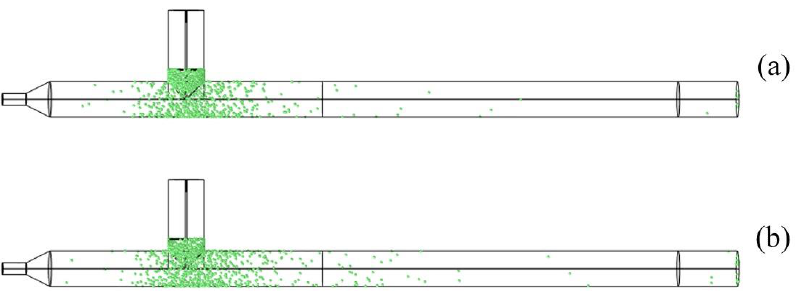
Figure 8. Particle distribution with different applied voltages on the nozzle and ring electrode: ( a ) nozzle voltage of 6000 V and grounded ring; ( b ) nozzle voltage of 7000 V and ring voltage of 500 V.